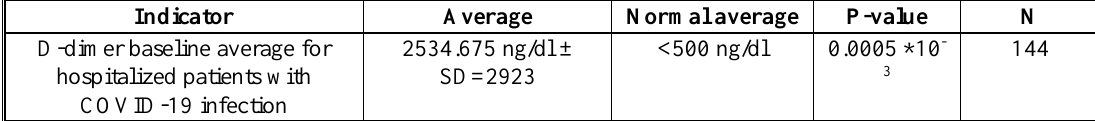
Table 1. D-dimer baseline average for hospitalized, COVID-19 infected patients before receiving any treatment .